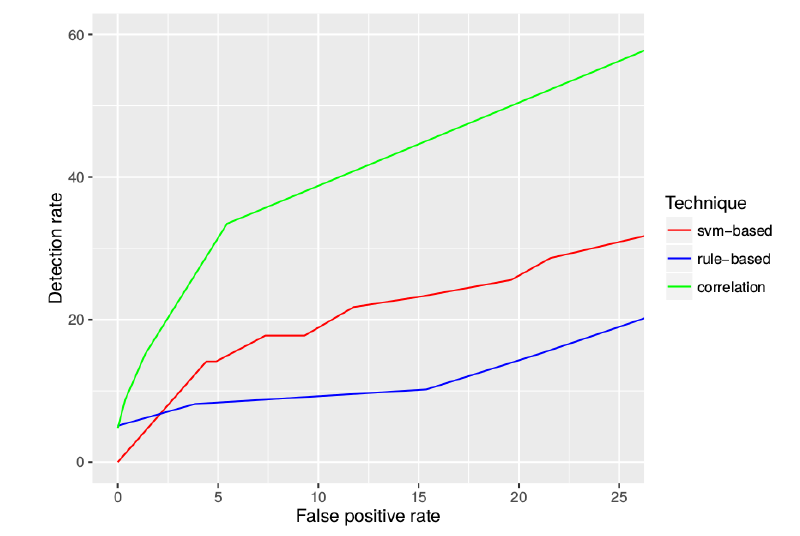
Figure 7. Evolution of the detection rate and the false positive rate of the three techniques. In the rule-based detection, increasing the packet loss threshold decreases the detection rate and the false positive rate (e.g. defining threshold = 9 results in a 10.20% detection rate and a 15.38% false positive rate; defining threshold = 10 results in a 8.16% detection rate and a 3.85% false positive rate). In the one-class (OC)-SVM detection, a higher value of the hyperparameter ν increases the detection rate and the false positive rate (e.g., defining ν = 0.01 results in a 14.12% detection rate and a 4.41% false positive rate; defining ν = 0.02 results in a 17.75% detection rate and a 9.31% false positive rate). In the detection by correlation, including more alarms in the correlation rule decreases the detection rate and the false positive rate (e.g., aggregating two alarms from any of the two systems results in a 33.47% detection rate and a 5.45% false positive rate; aggregating three alarms results in a 15.14% detection rate and a 1.36% false positive rate).